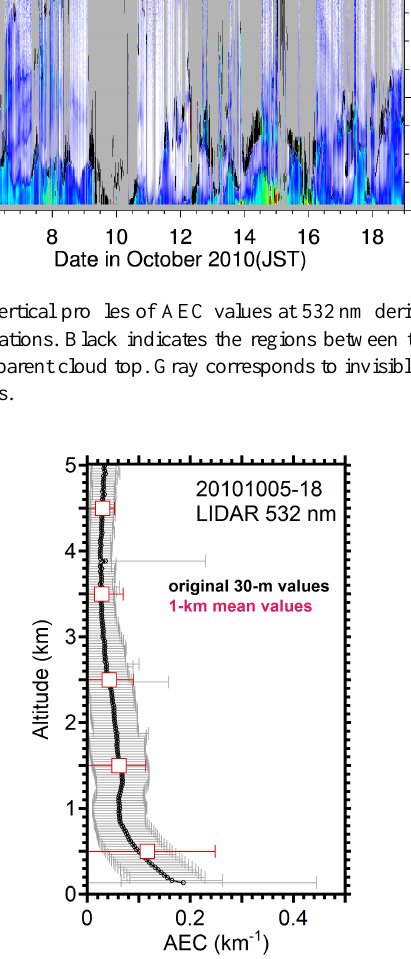
Figure 3. Mean vertical profiles of lidar AEC data at 532nm for 5–18 October 2010. Profiles with the original vertical resolution (30m) and 1km mean profiles are shown in black and red, respec- tively. In this period, there are significant amounts of AECs even above 2km. Error bars represent 1 σ standard deviations.